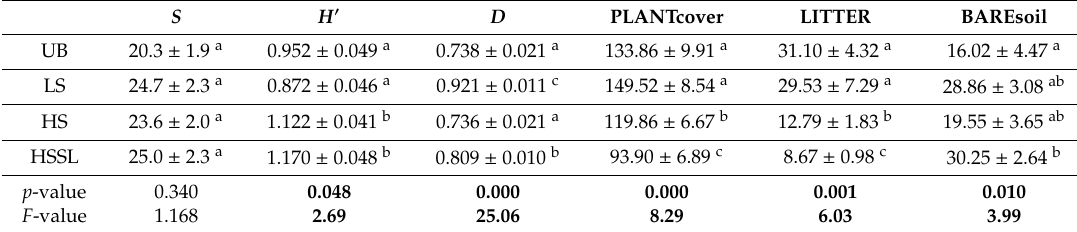
Table 1. Analysis of variance (one-way ANOVA) of the recorded variables used to characterize α -diversity ( S , H (cid:48) , D ) and soil protection (PLANTcover, BAREsoil, LITTER,). Di ff erent lowercase letters in each column indicate significant di ff erences between the means of groups (Tukey honest significant di ff erence (HSD), p < 0.05). Significant values are highlighted in